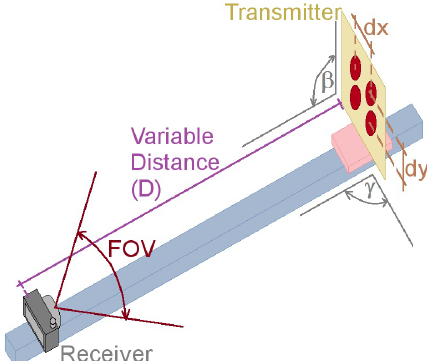
Figure 2. Experimental testbed design for determining the optical interference of close emitters and for validating the relation between projected pixels and real distances. For all the experiments β was set to 90 ◦ , γ and D varied according to the test parameters.